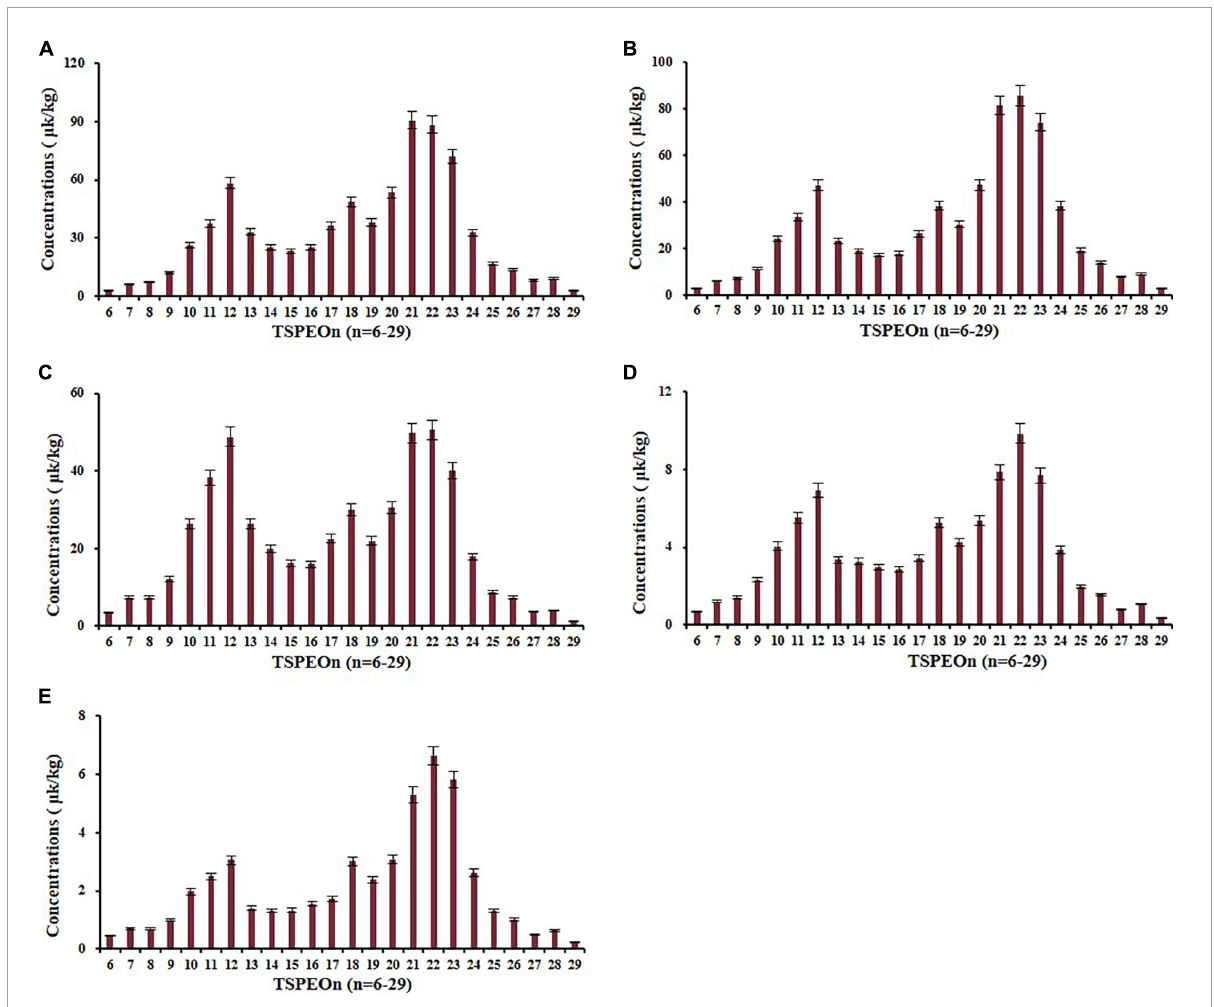
FIGURE5 Concentration distribution of homolog tristyrylphenol ethoxylates (TSPEOn) ( n = 6–29) under 450 g/ha after two applications at different interval to harvest in cowpea in terminal residue experiments in China. Interval to harvest: (A) 5 d; (B) 7 d; (C) 10 d; (D) 14 d; (E) 21 d.